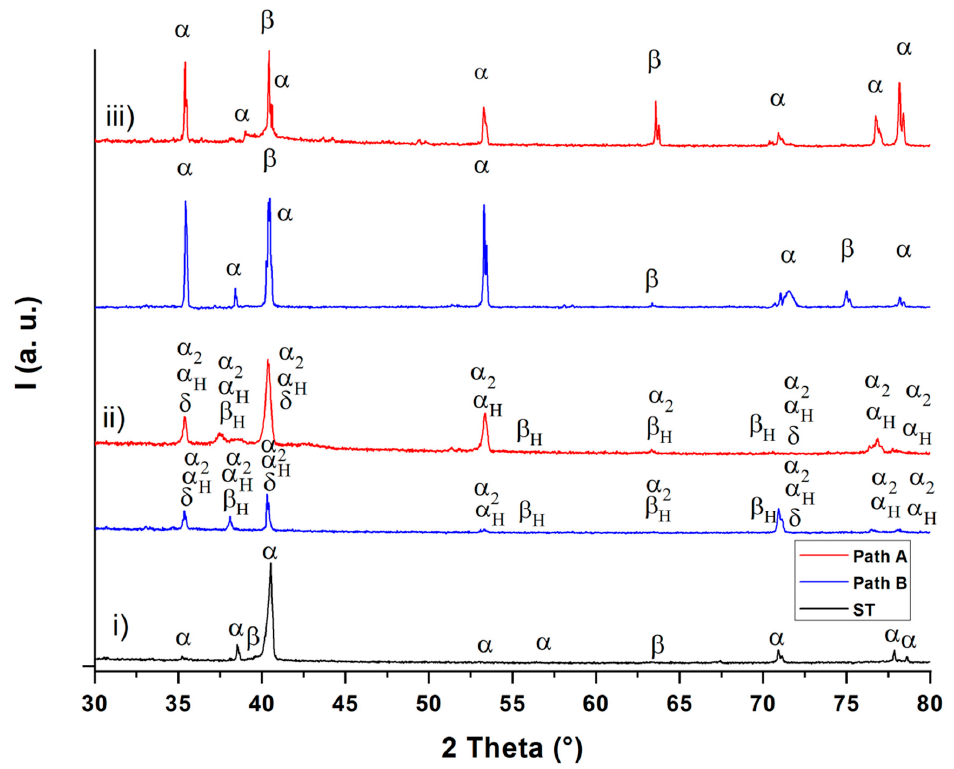
Figure 6. XRD diffractograms after solution treatment (ST) ( i ), hydrogenation ( ii ) and dehydrogenation ( iii